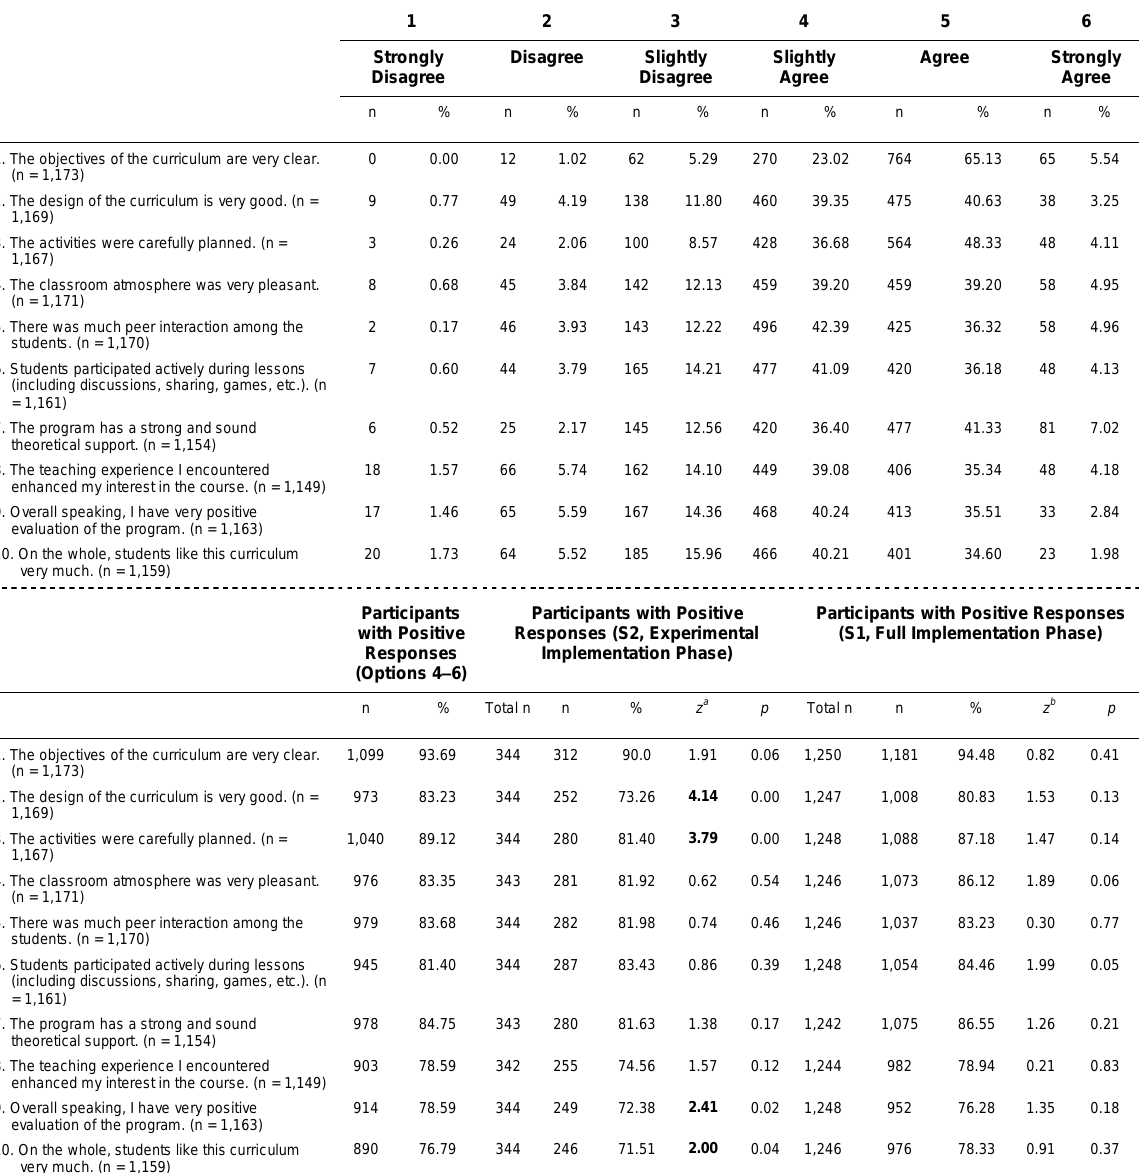
Summary of the Views of the Program Implementers of the Program